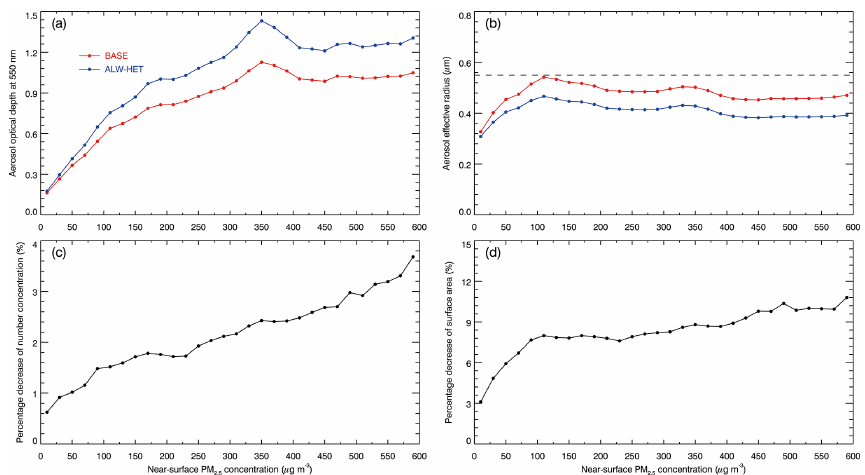
Figure 16. Average variations in (a) AOD and (b) Reff in f base (red line) and f alw_het0 (blue line), respectively, and average percentage decrease in near-surface (c) aerosol number concentration and (d) surface area caused by the ALW-HET as a function of bin [PM 2 . 5 ] in NCP from 5 December 2015 to 4 January